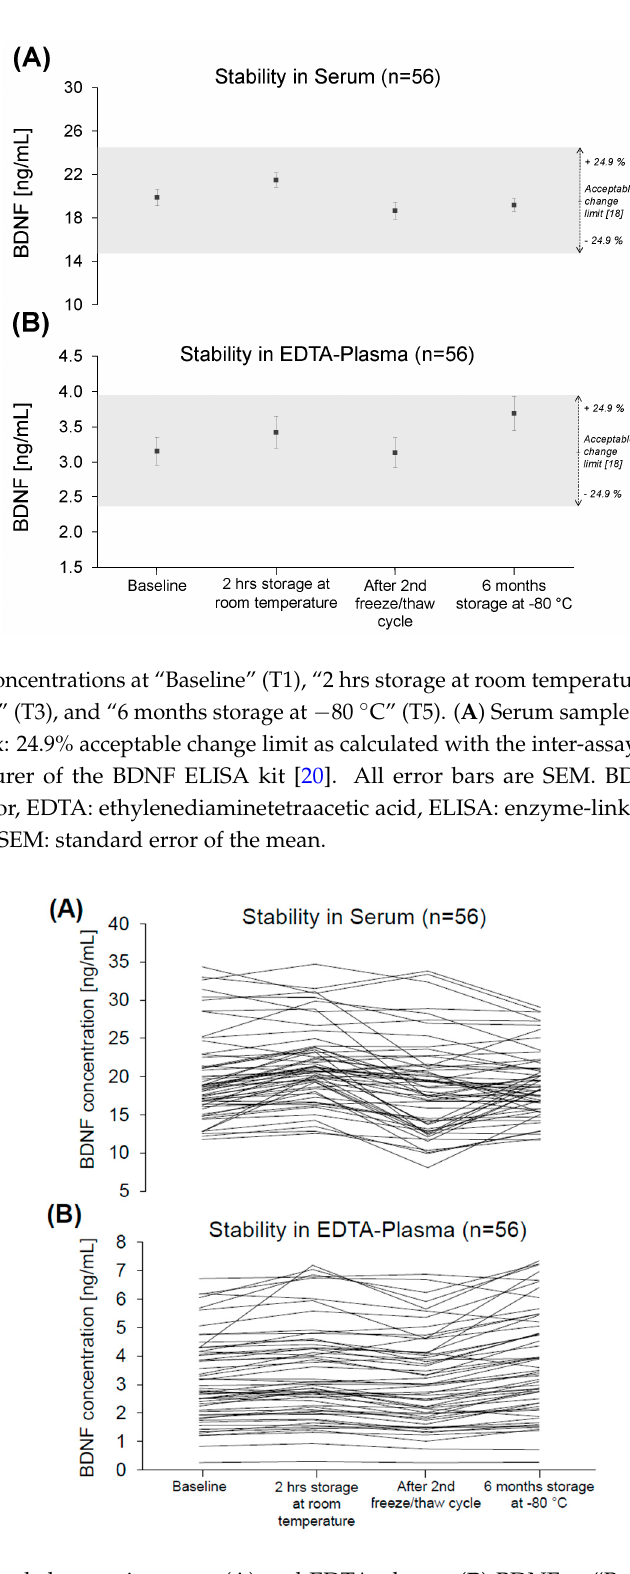
Figure 3. Individual changes in serum ( A ) and EDTA-plasma ( B ) BDNF at “Baseline” (T1), “2 hrs storage at room temperature” (T2), “After 2nd freeze/thaw cycle” (T3), and “6 months storage at − 80 °C” (T5). BDNF: brain-derived neurotrophic factor, EDTA: ethylenediaminetetraacetic acid, hrs: hours.